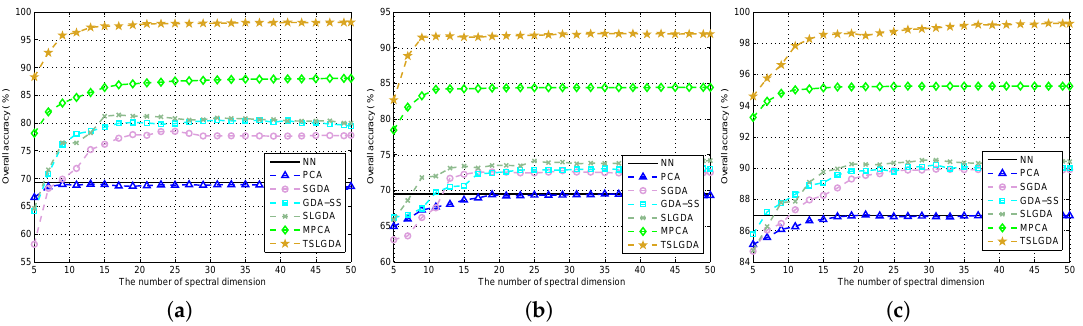
Figure 4. Overall accuracy versus the reduced spectral dimension for different methods using three datasets: ( a ) Indian Pines; ( b ) University of Pavia; ( c )